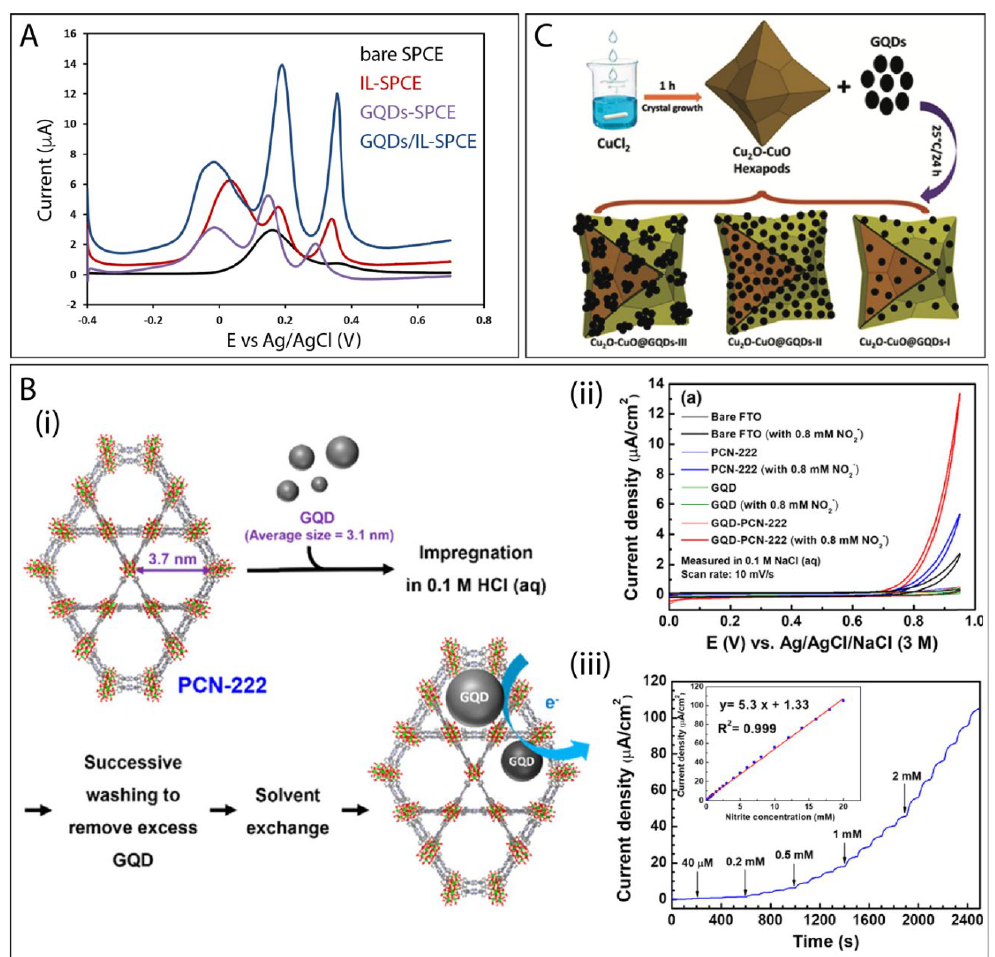
Figure 7. ( A ) DPVs of bare SPCE, IL-SPCE, GQDs-SPCE, and GQDs/IL-SPCE in 0.1 M PBS (pH 4.0) containing 400 μM